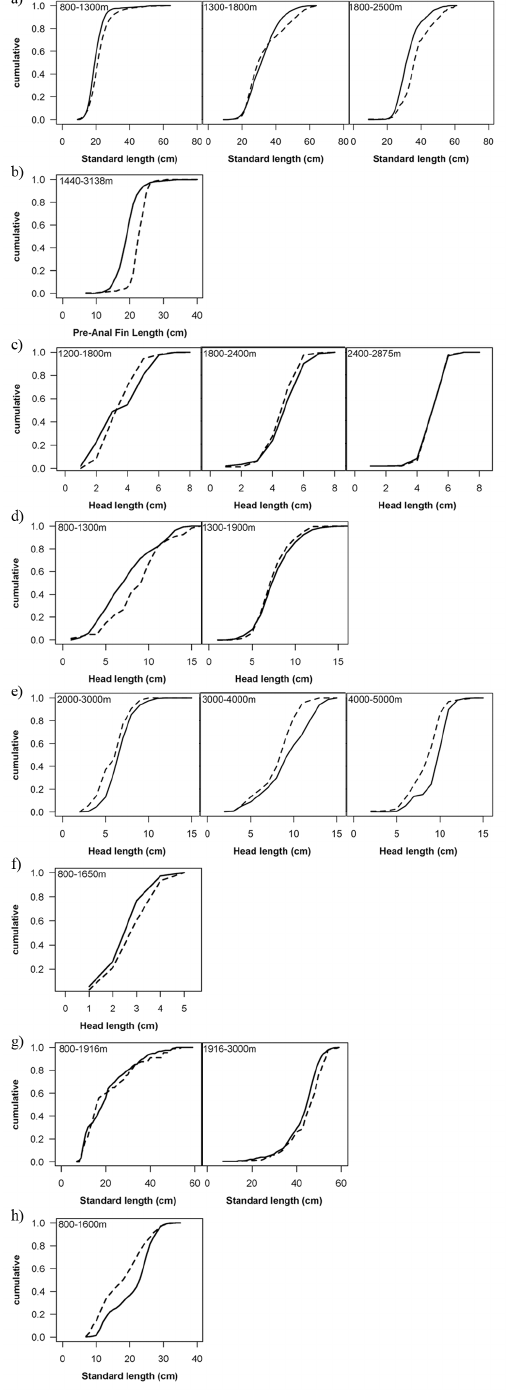
Fig. 6. Cumulative percentage length distribution of (a) Syna- phobranchus kaupii , (b) Halosauropsis macrochir , (c) Cor- (e) Coryphaenoides armatus , (f) Nezumia aequalis , (g) An- timora rostrata and (h) Lepidion eques for different depth strata. Solid line — early period = 1977–1989, dashed line --- late period =